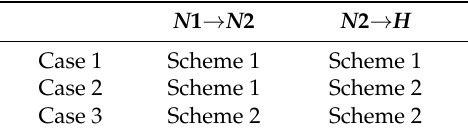
Table 5. Cases for the proposed scheme of each